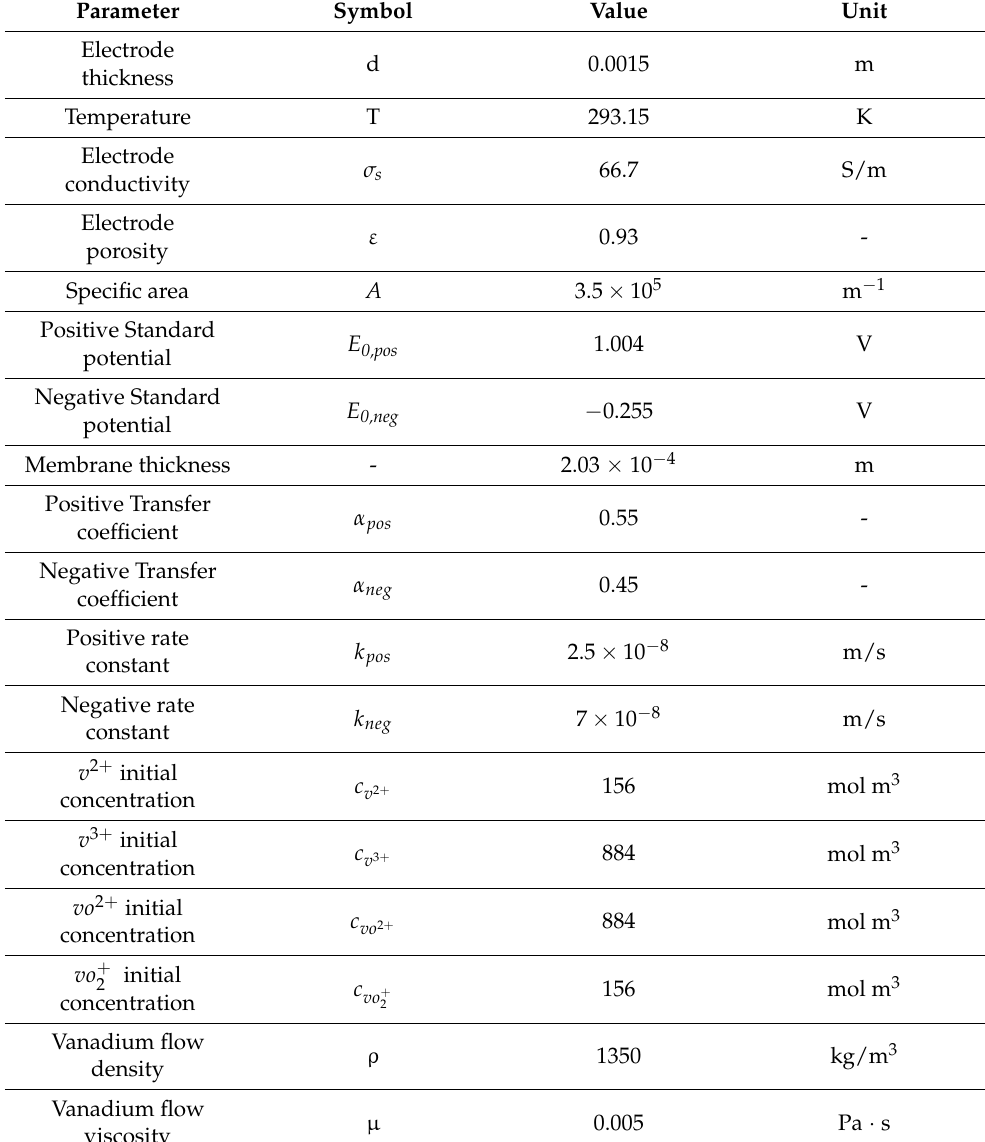
Table 1. Parameter used in the